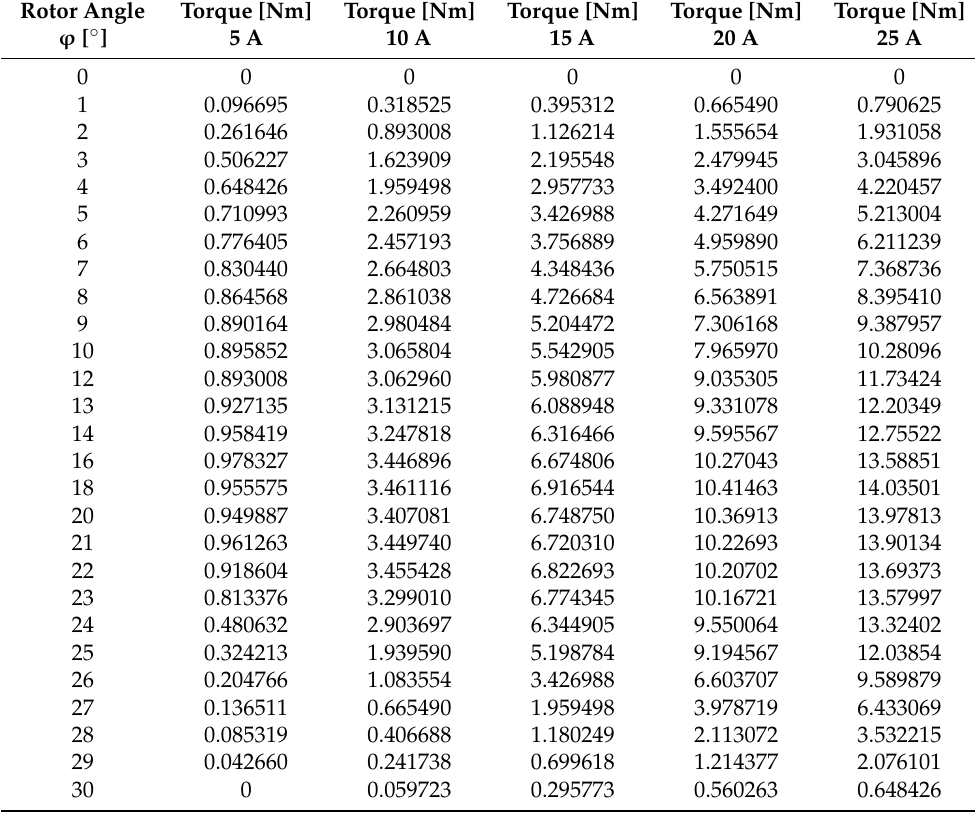
Table 8. An 8/6 motor: torque values for individual angles’ and currents’ values derived from laboratory